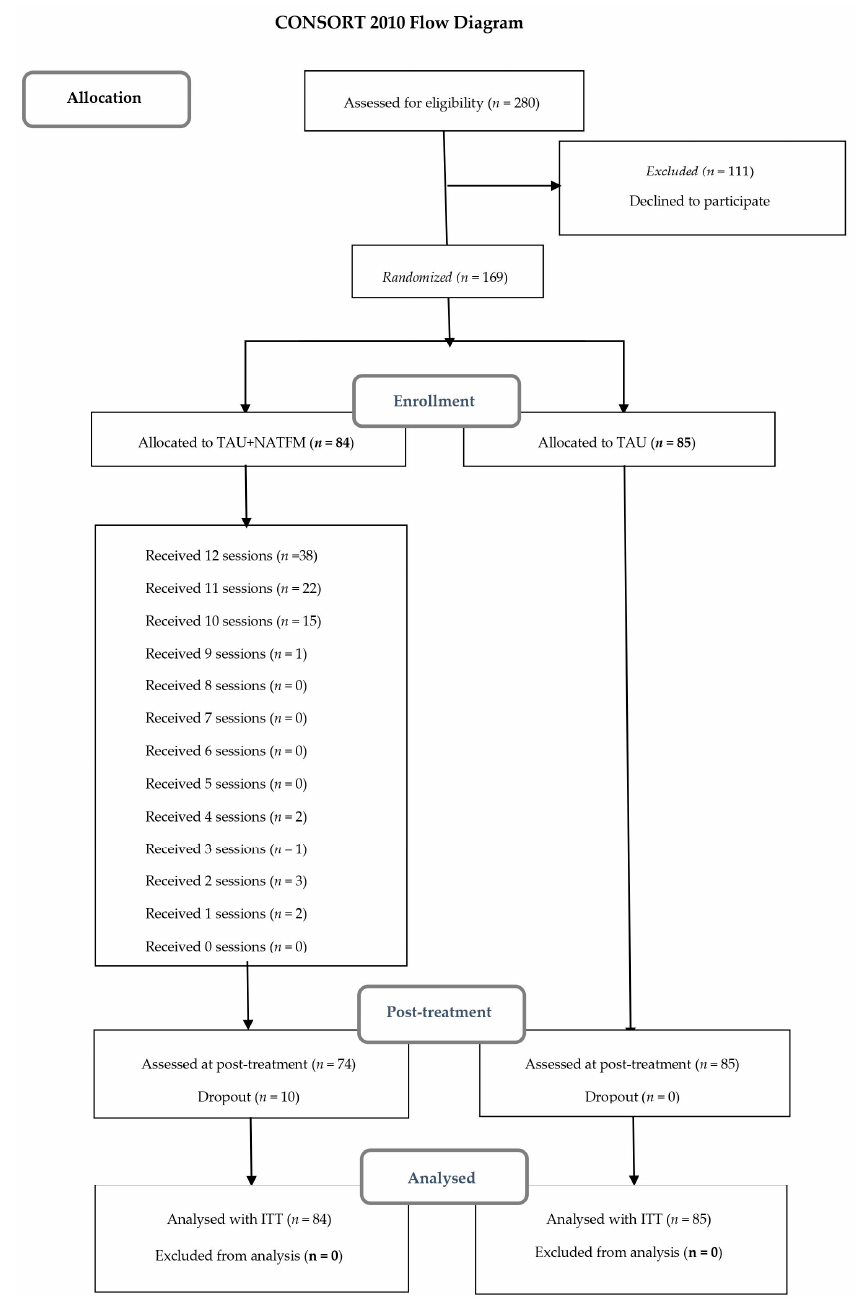
Figure 1. Flowchart of the nature activity therapy for fibromyalgia (NAT-FM) study following the Consolidated Standards of Reporting Trials (CONSORT) statement. ITT, intention-to-treat; n = 0 indicates that none of the participants attended the specified number of sessions.